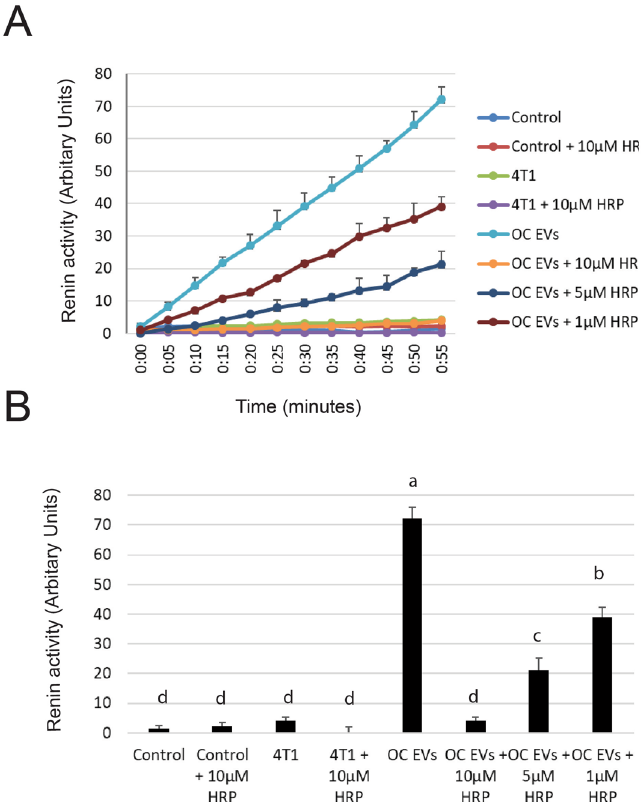
Figure 4. Handle Region Peptide (HRP) dose-dependently blocks activation of (pro)renin by EVs from osteoclasts. ( A ) EVs from osteoclasts (5 × 10 7 ) stimulated (pro)renin activity, while activity was not stimulated by PBS control or EVs from 4T1 cells (5 × 10 7 ). Addition of the HRP peptide dose-dependently reduced the stimulation of (pro)renin activity. ( B ) At 55 min, 1, 5 and 10 µM HRP reduced the ability of osteoclast EVs to stimulate (pro)renin activity in a statistically-significant manner. Letters indicate that group is different p < 0.05 by Student’s t test from groups with other letters within the